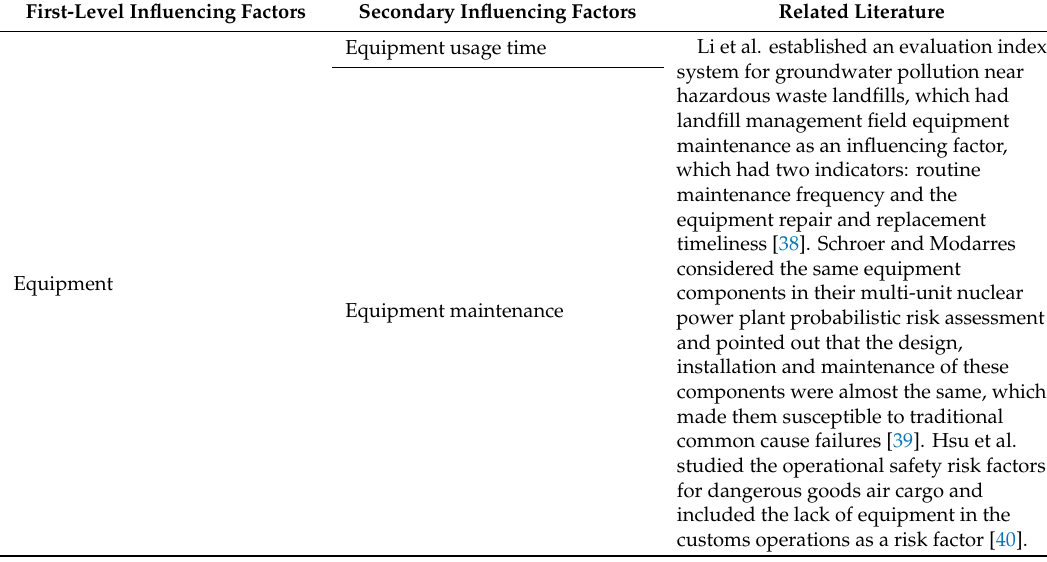
Table 2. Hazardous waste inventory risk factor analysis